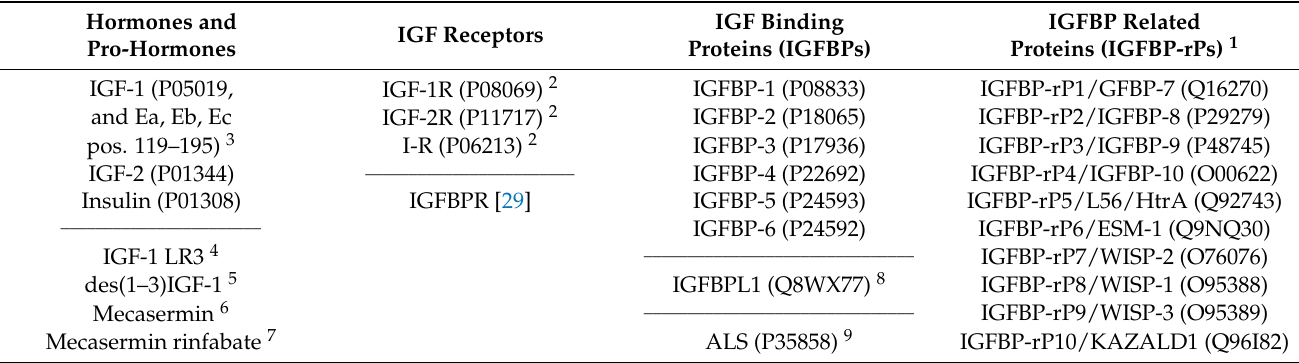
Table 1. Human insulin-like growth factor-1 (IGF-1) and related other hormones and their binding proteins. Hormones and